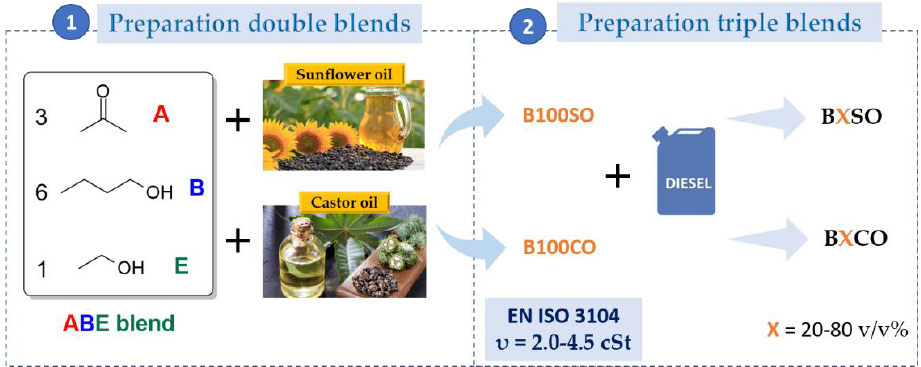
Figure 1. Procedure employed for the preparation of (bio)fuel